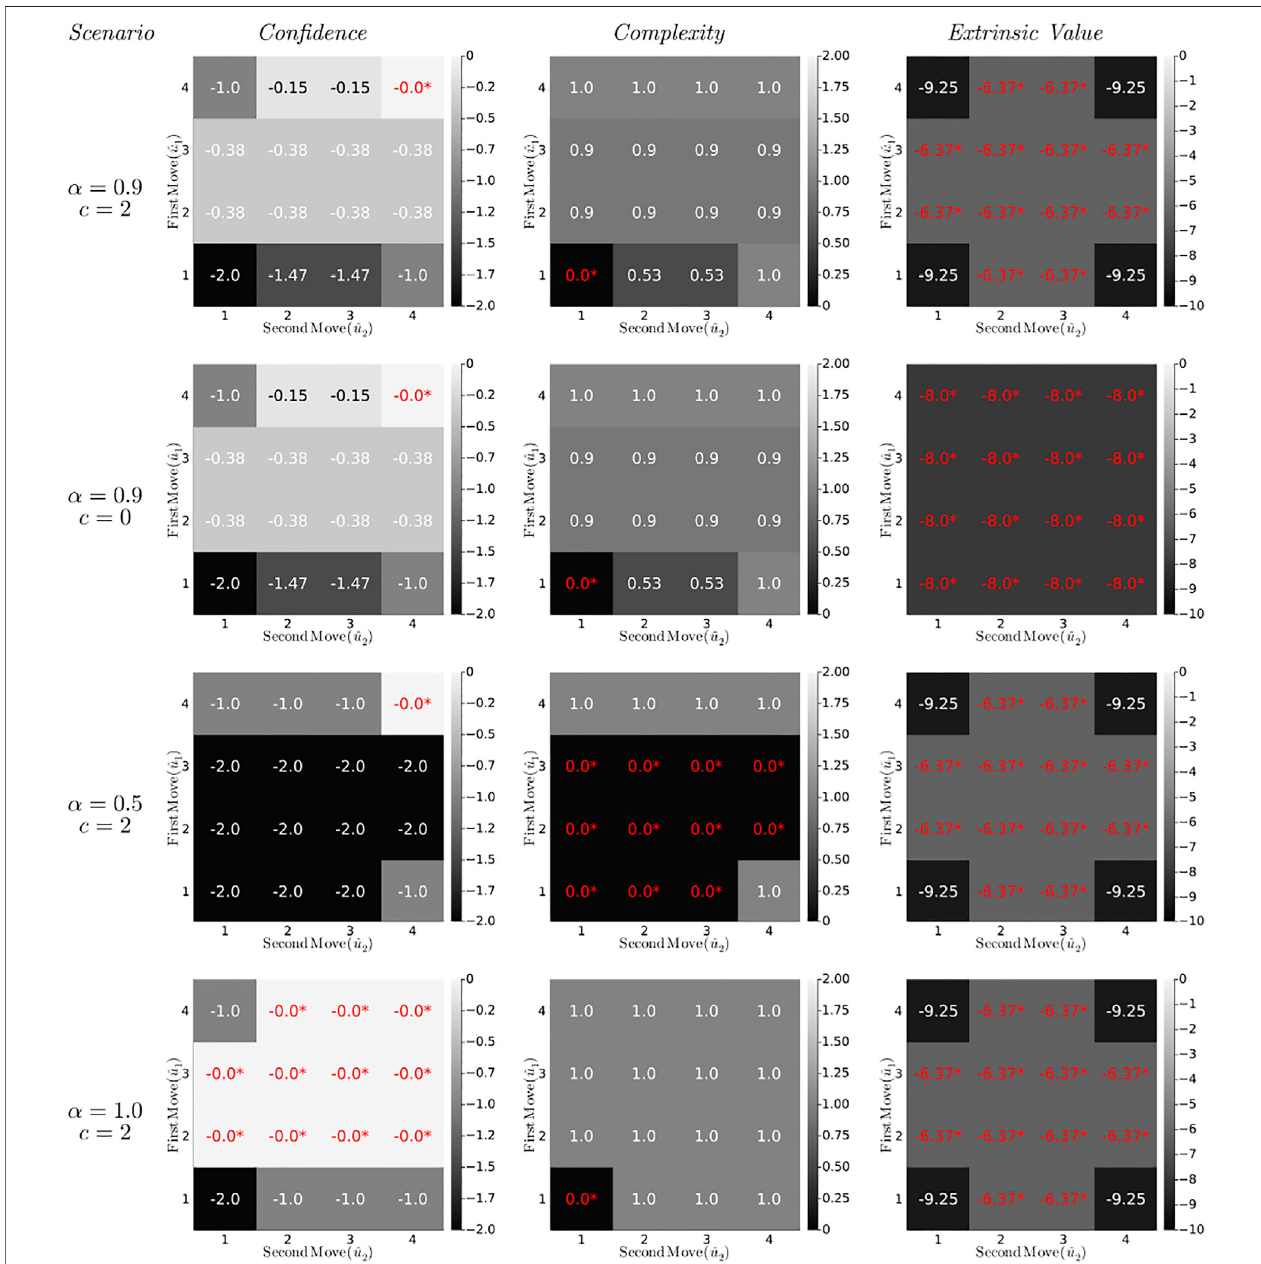
FIGURE 8 | Con fi dence, complexity and extrinsic value contributions (in bits) to the Constrained Bethe Free Energy (32) for the T-maze policies (lookahead T = 2) under varying parameter settings. Optimal values are indicated red with an asterisk.